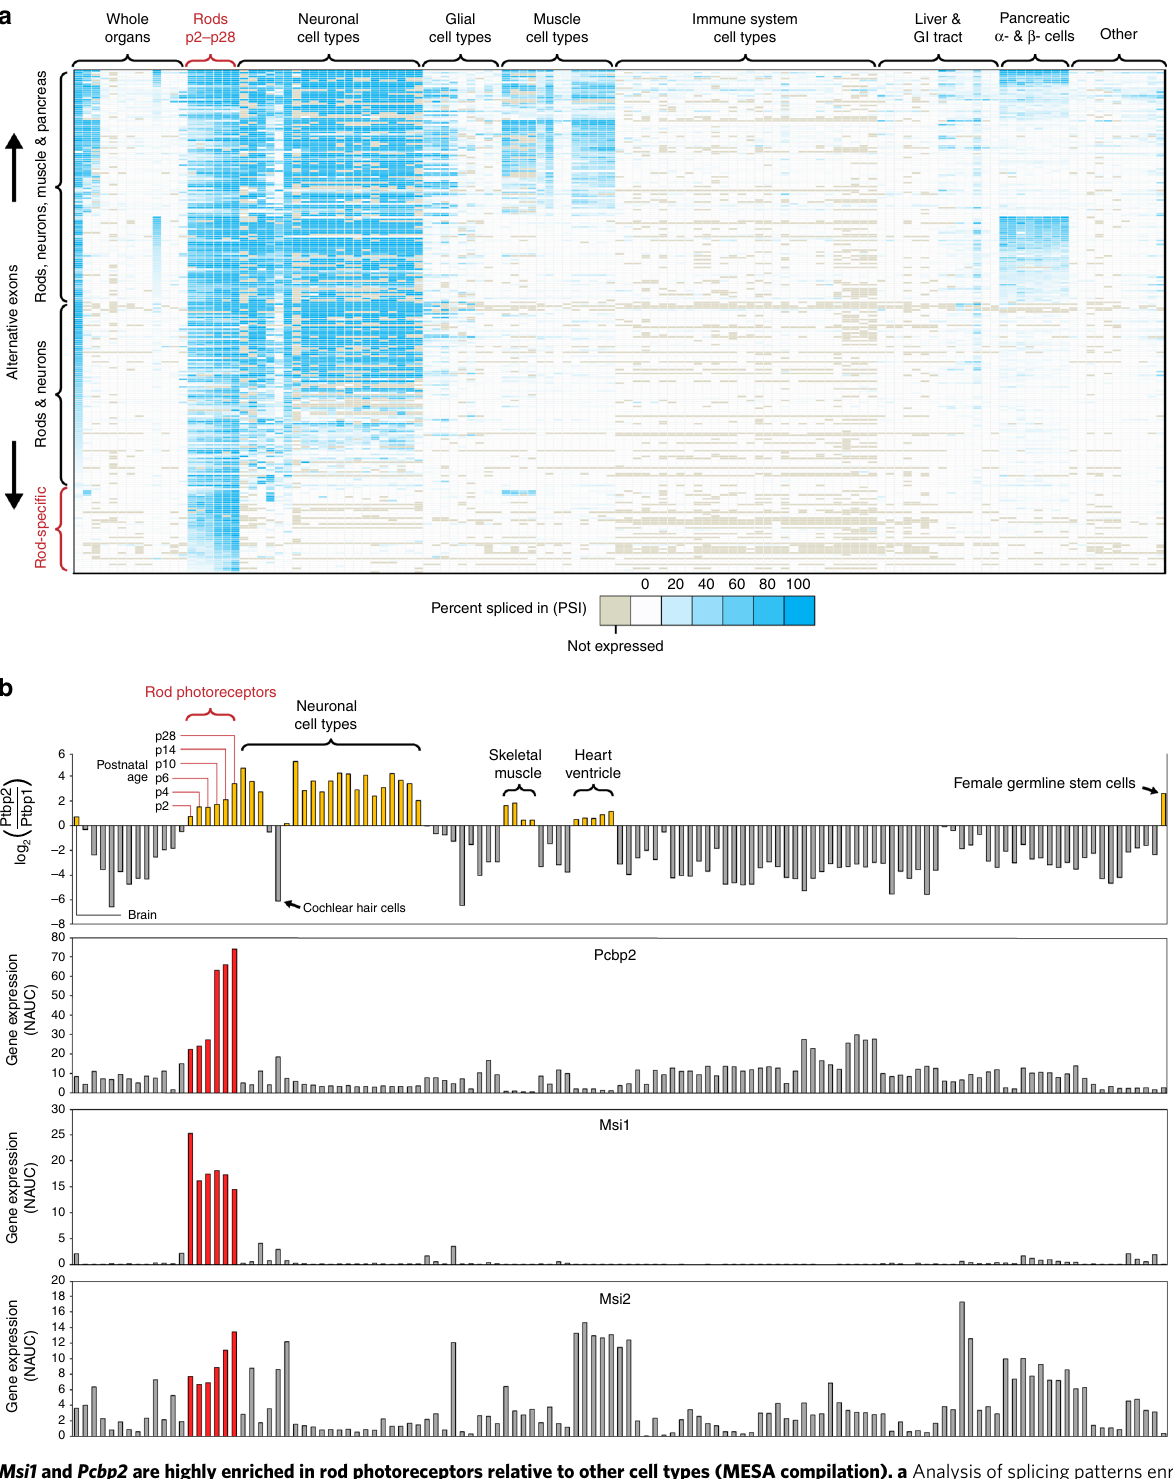
Fig. 3 Msi1 and Pcbp2 are highly enriched in rod photoreceptors relative to other cell types (MESA compilation). a Analysis of splicing patterns enriched in mouse rods reveals some exons that overlap with neurons, muscles, or pancreatic α and β -cells but also exons that are rod-speci fi c and not present in other cell types. b Similarly to other neurons, rods downregulate Ptbp1 and upregulate Ptbp2 . The Ptbp2/Ptbp1 ratio gradually increases in rods over development from P2 to P28. However, we also fi nd that cochlear hair cell sensory neurons retain high levels of Ptbp1 , suggesting that perhaps not all neurons switch from using Ptbp1 to Ptbp2 . To identify the factors that might mediate the splicing of rod-speci fi c exons, we cross referenced genes with expression patterns that were enriched in rods with a list of putative RBPs and identi fi ed Msi1 and Pcbp2 as potential candidates. Note that the expression of Msi2 , a paralog to Msi1 , does not show the same selectively high expression in